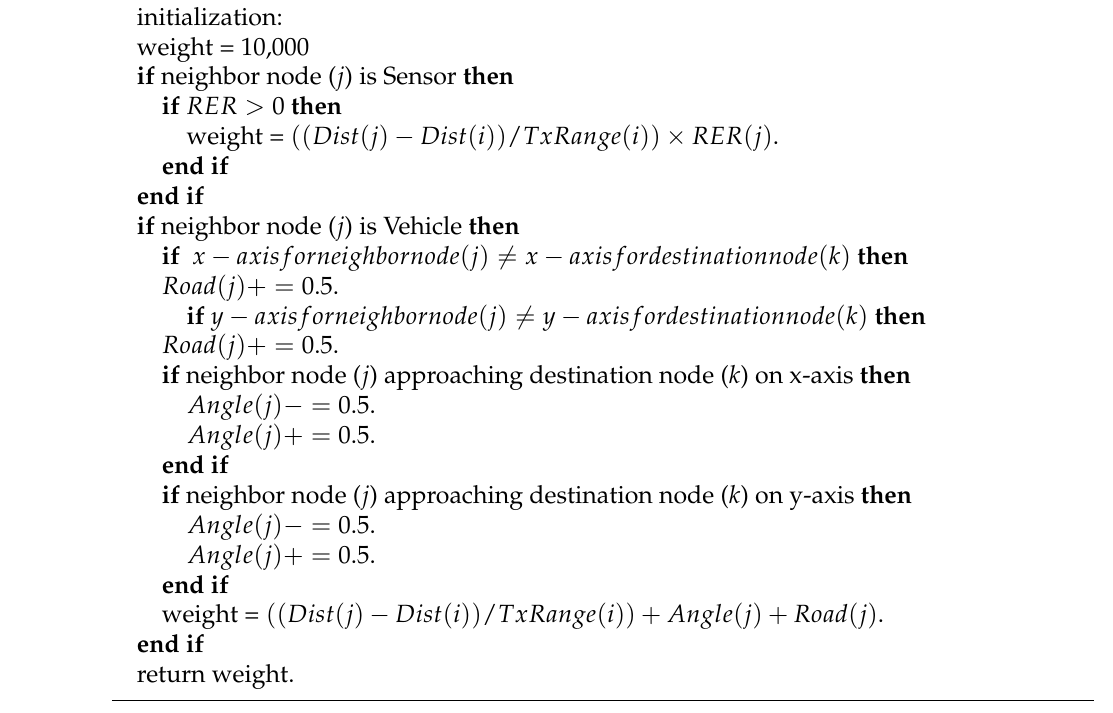
Figure 4. Examples for a forwarder sensor and the weight calculation for its neighbors. ( a ) Example 1. ( b ) Example 2. Algorithm 3 Weight calculation for the neighbor nodes